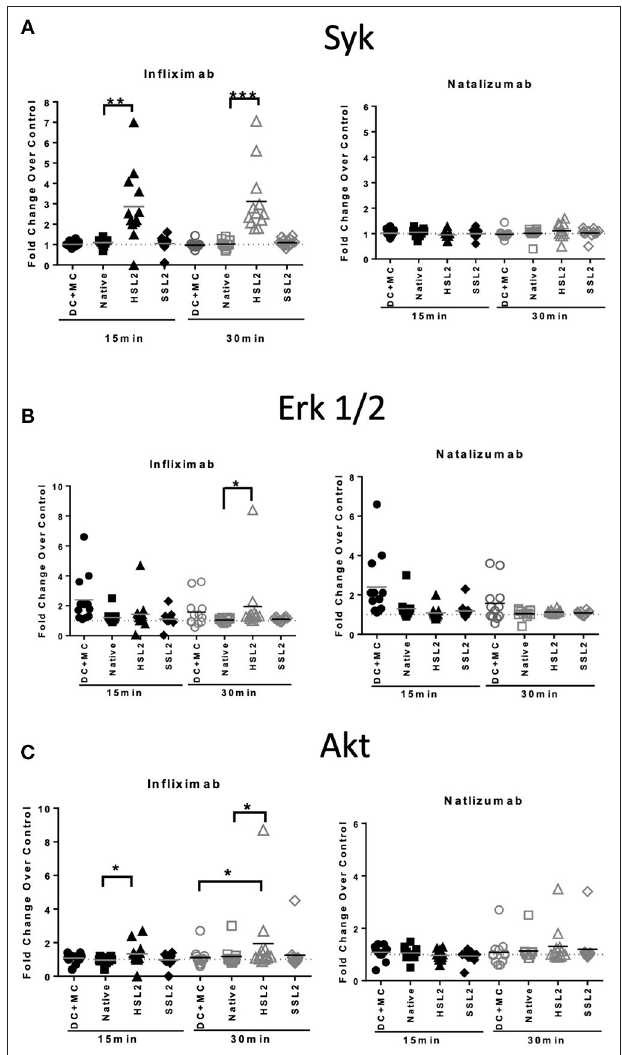
FIGURE 7 | Protein phosphorylation in moDC treated with native or aggregated infliximab and natalizumab. (A) Syk phosphorylation, (B) ERK 1/2 phosphorylation, and (C) Akt phosphorylation. MoDC were treated with 100 µ g/mL native or aggregated antibodies. Phosphorylation was detected following 15 and 30min of stimulation. Results are expressed as fold change over PBS control. The results from 12 independent experiments are shown. * p < 0.05; ** p < 0.01; *** p <